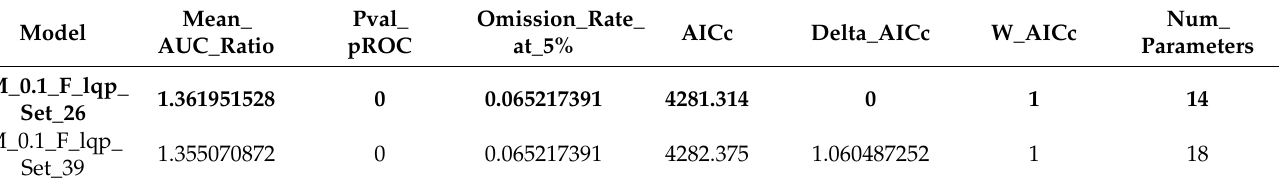
Table A1. Performance statistics for the best models selected based on the user’s pre-defined